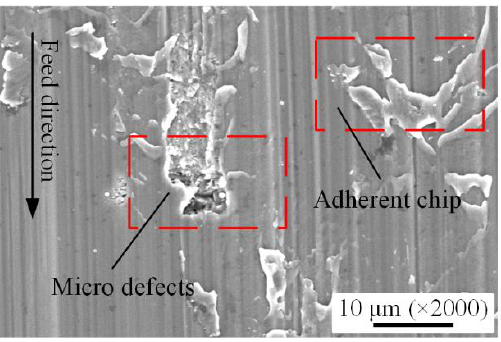
Figure 6. Partial enlargement of surface topography after dry milling.